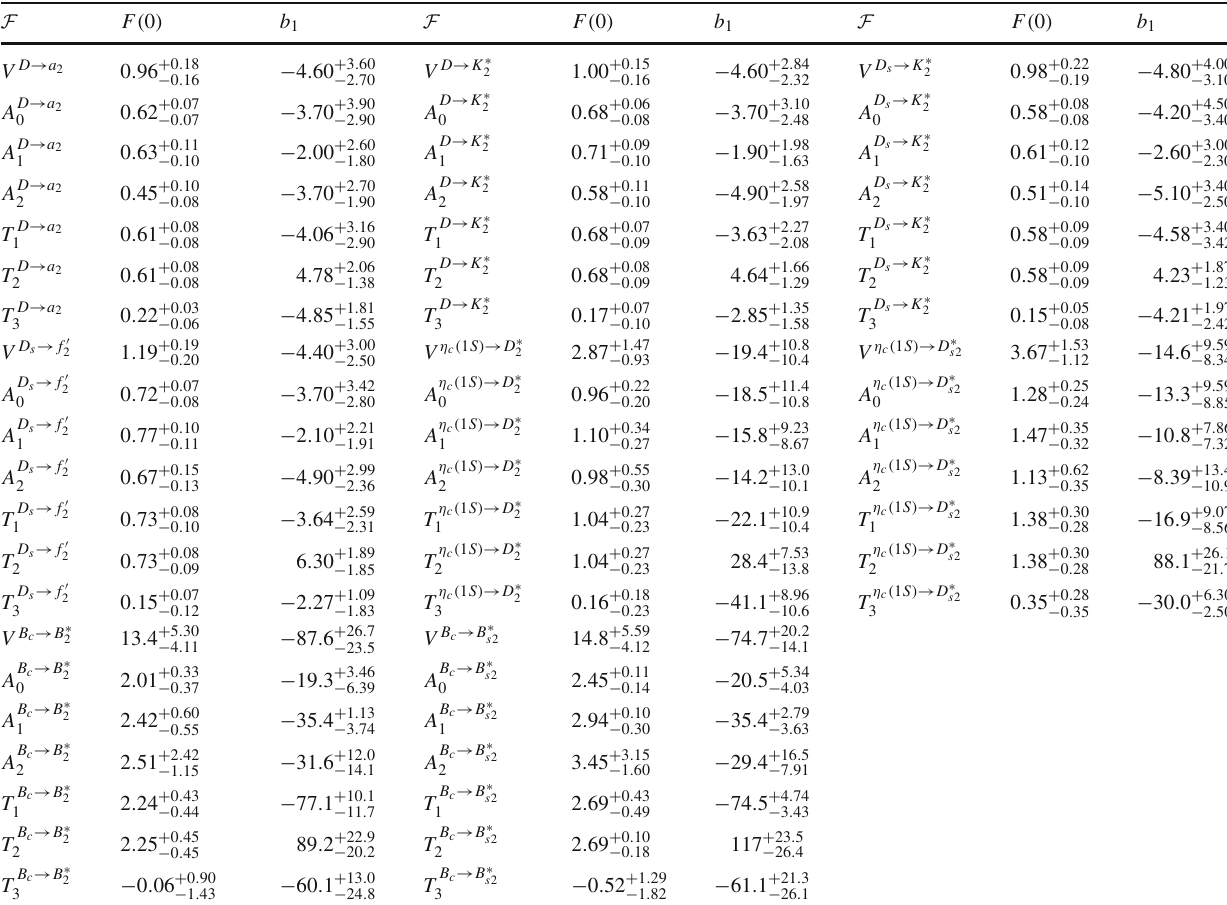
Table 3 Fitting results for form factors of c → ( q , s ) induced D → ( a 2 , K ∗ with the parameterization scheme given by Eq.